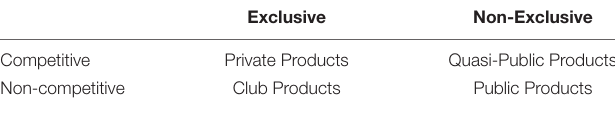
TABLE 1 | The classification of public